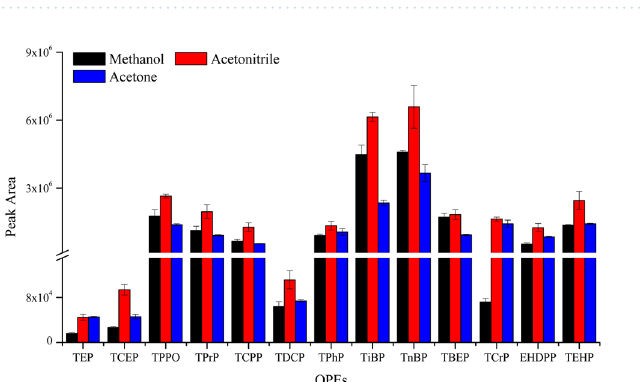
Figure 2. The efficiency of different extractant volumes on the extraction of OPEs from aqueous samples (n = 3).